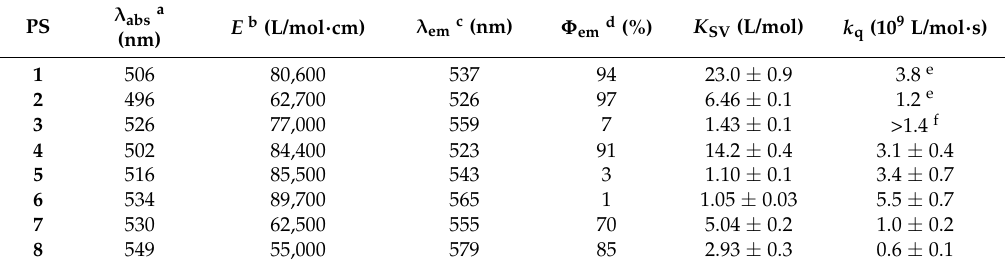
Table 1. Selected results from stationary optical spectroscopy. All measurements were conducted on 10 − 5 M solutions of the dyes in THF ( λ abs : wavelength of the maximum absorption, ε : absorption coefficient at the wavelength of maximum absorption, λ em : wavelength of the maximum emission, K SV : Stern–Volmer constant from TEA quenching experiments, k q = K SV / τ em ).